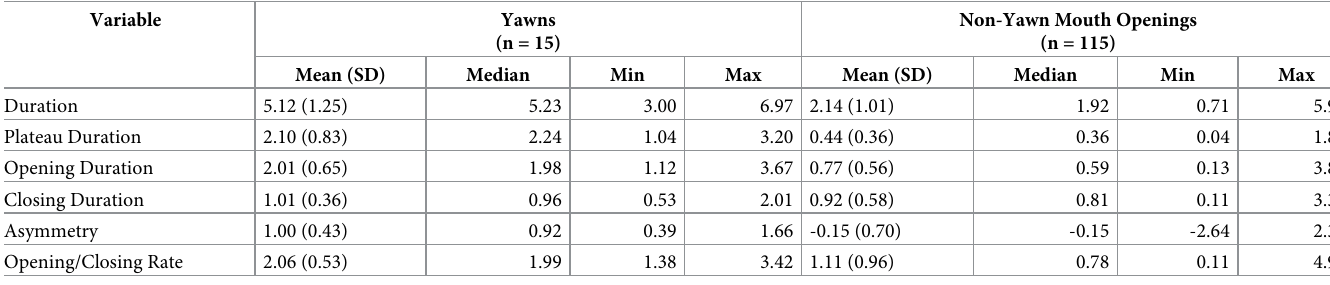
Table 3. Variables related to temporal dynamics of yawns and non-yawn mouth